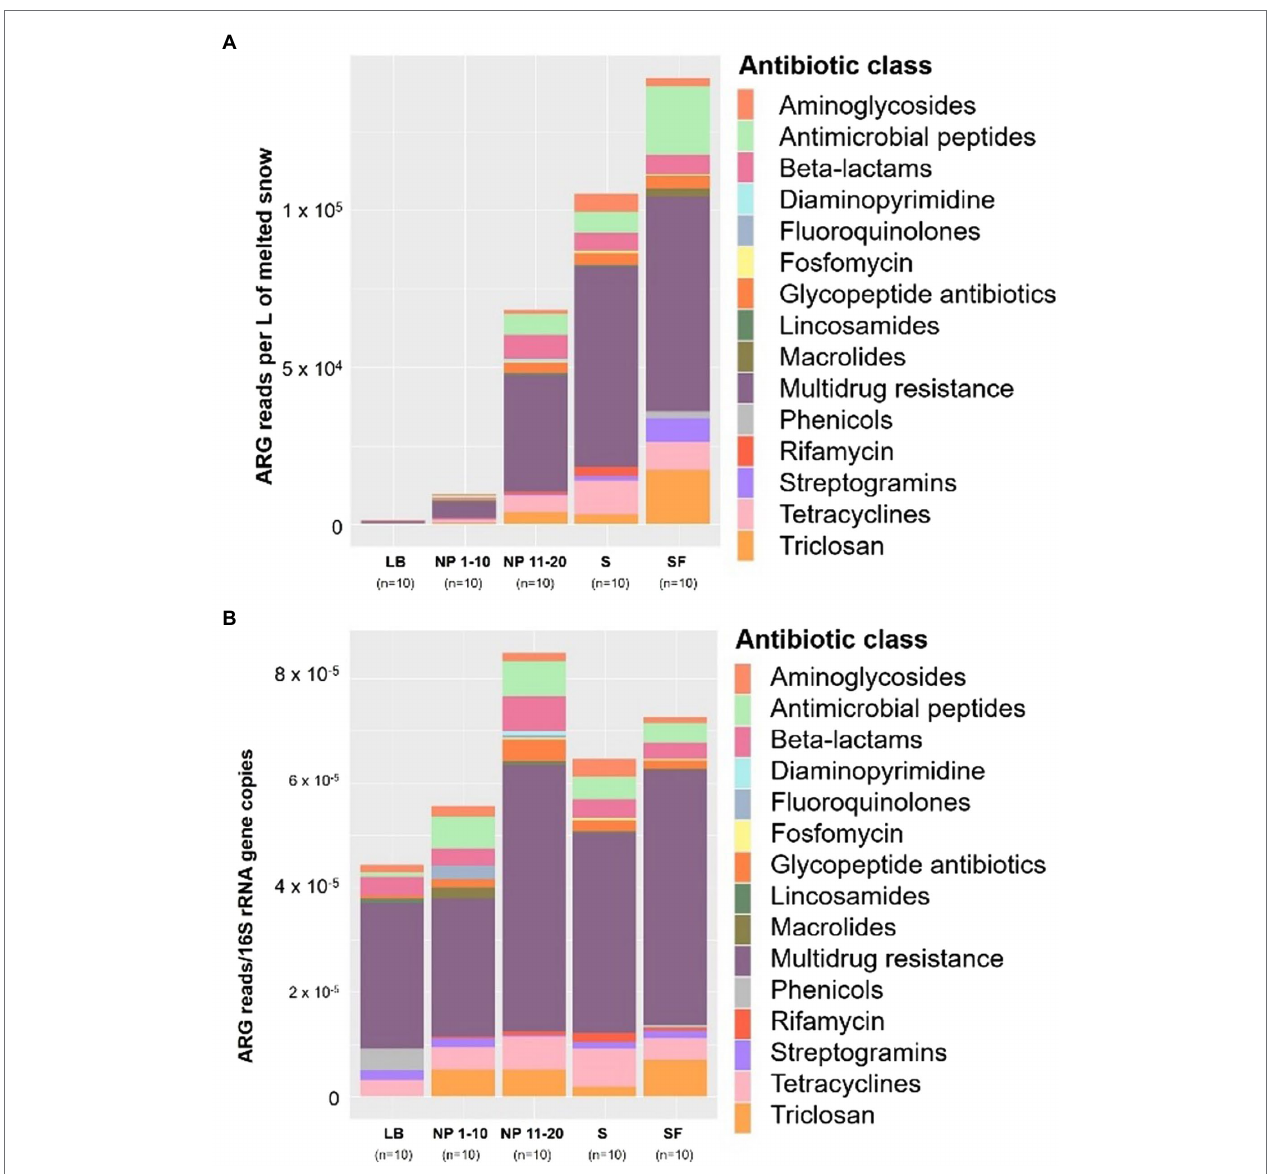
FIGURE 4 | Total ARG copies per site normalized (A) by L of melted snow and (B) by copies of the 16S rRNA gene (right) grouped by antibiotic class. LB: ridge from the catchment with human transit. NP 1–10: open spaces from the unaffected catchment. NP 11–20: forested area from the unaffected catchment. S: paths from the catchment with human transit. SF: forest areas from the catchment with human transit. n =